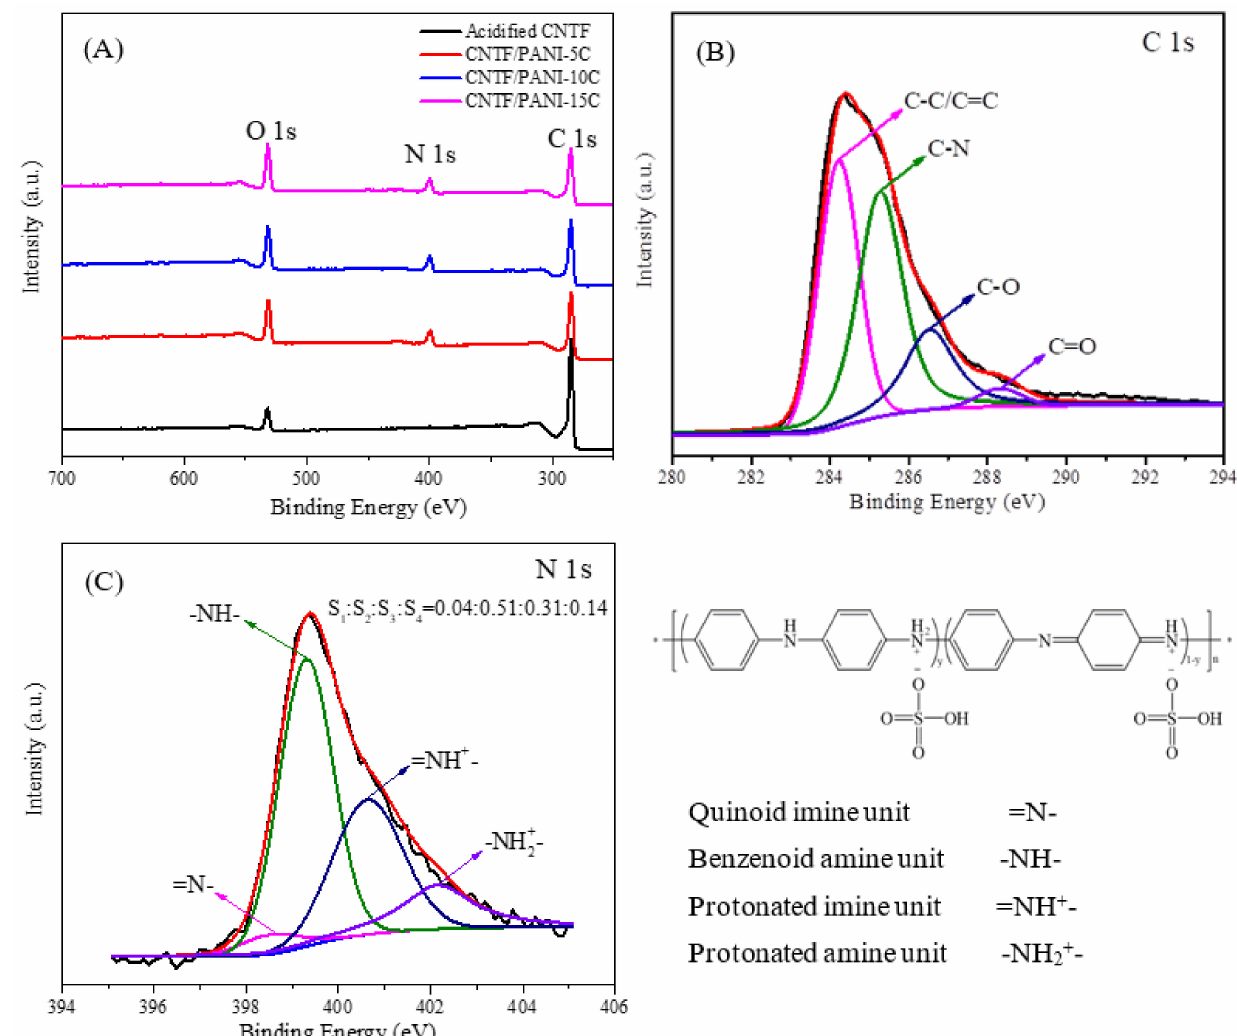
Figure 6. ( A ) X-ray photoelectron spectra of acidified CNTF and CNTF/PANI nanocomposites; ( B) C 1s spectrum; and ( C ) N 1s spectrum of CNTF/PANI-15C nanocomposites. The stress–strain curves of the acidified CNTF, CNTF/PANI-5C,